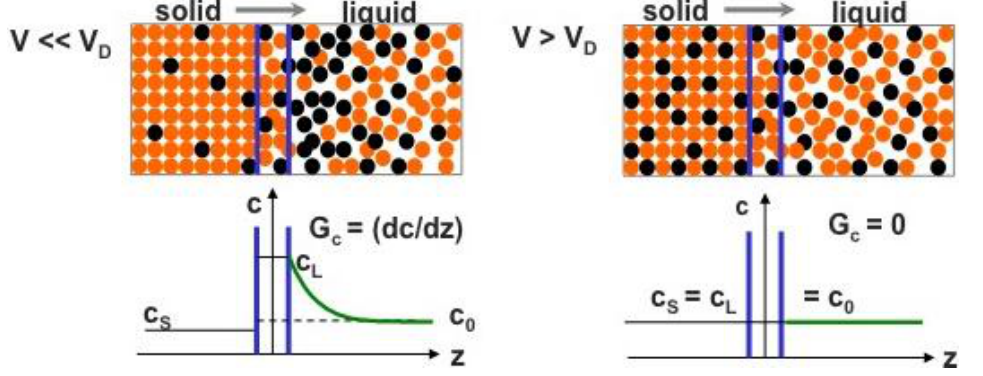
Figure 8. Illustration of solute partitioning at small dendrite growth velocity ( left ) and complete solute trapping at higher velocity ( right ). If the dendrite growth velocity V is less than the atomic diffusive speed V , solute atoms are segregating. In contrast if the growth D velocity is larger than the atomic diffusive speed solute is trapped in the solid leading to solidification of a supersaturated solid